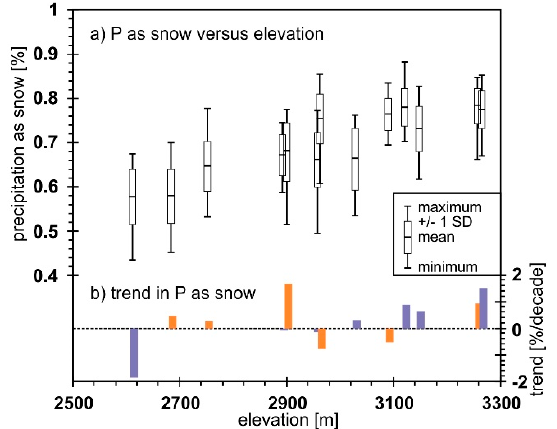
Figure 3. ( a ) Variation of precipitation as snow as a function of elevation, and ( b ) trend in the annual total precipitation as snow. Note that none of the trends are statistically significant.